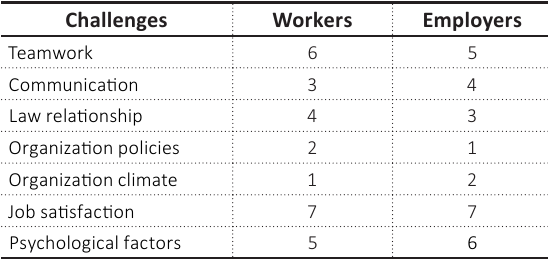
Table 7. Challenges of working online, %